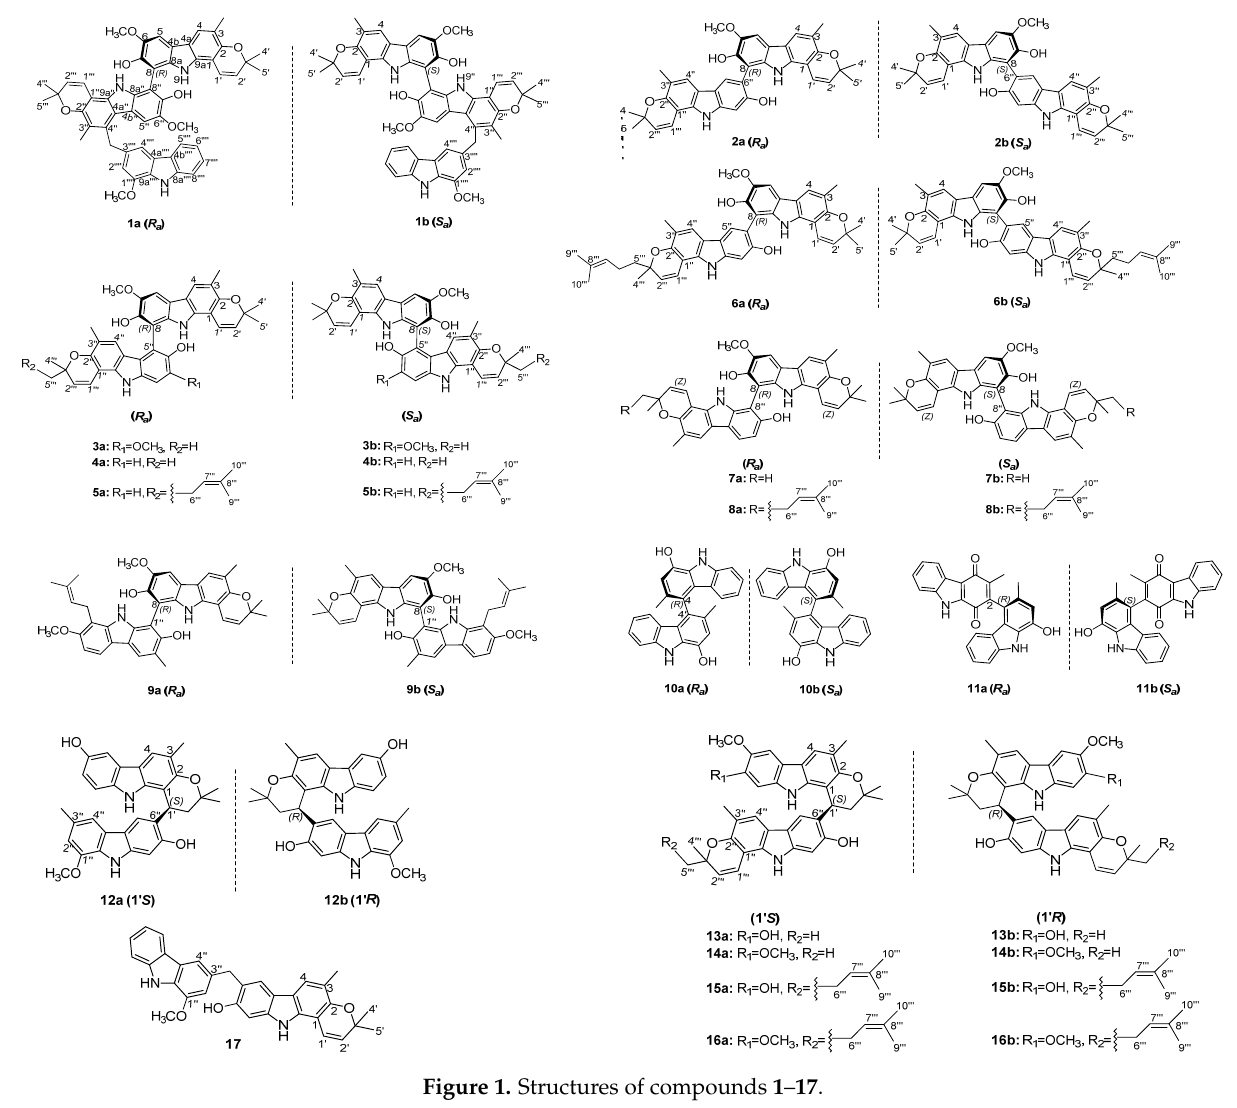
Figure 1. Structures of compounds 1 – 17.